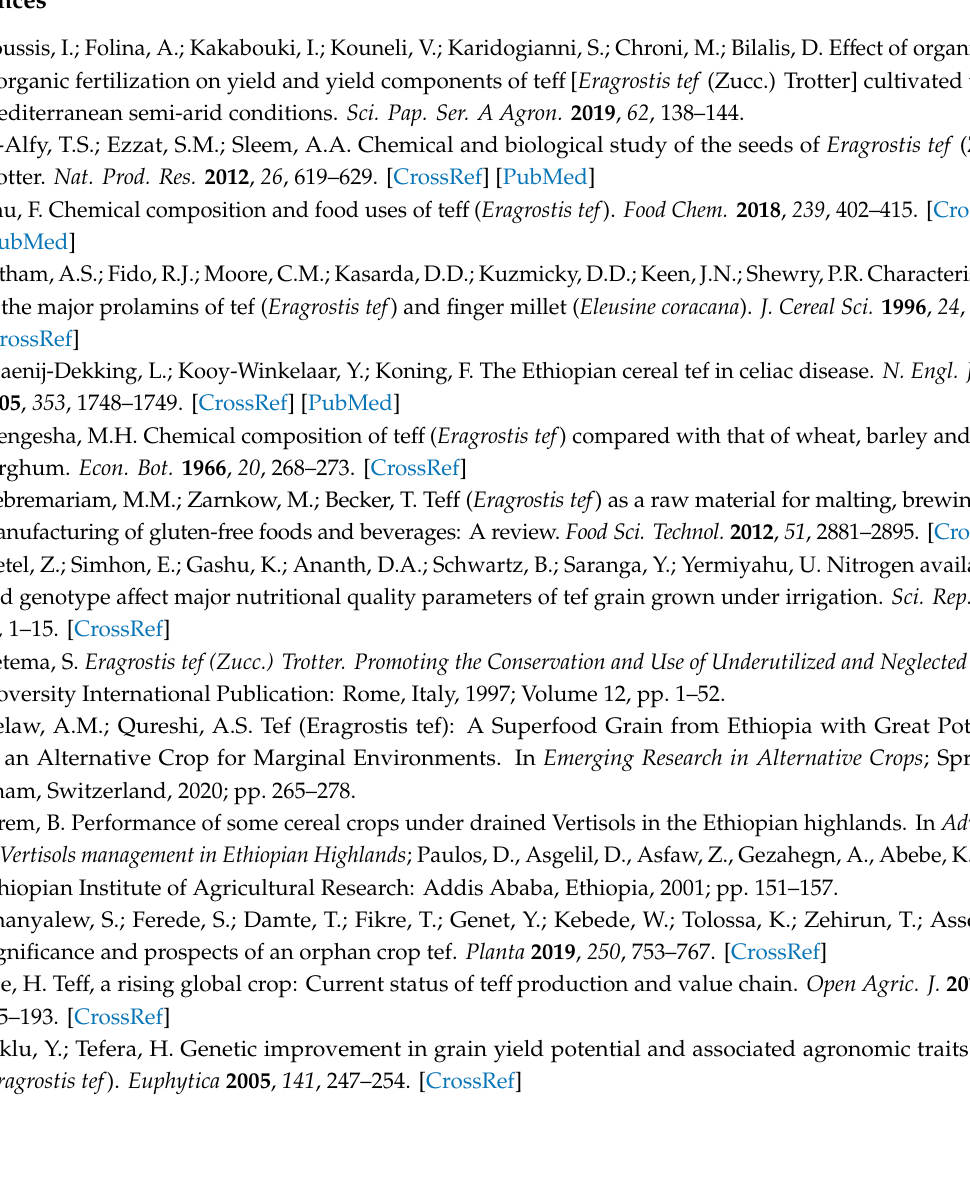
Table S1: Full Anova report for parameters in Table 2 from winter pot experiment Table S2: Full Anova report for parameters in Figures 3 and 4 from winter pot experiment Table S3: Full Anova report for parameters in Table 3 from summer field experiment. Table S4: Full Anova report for parameters in Figures 5–7 from summer field